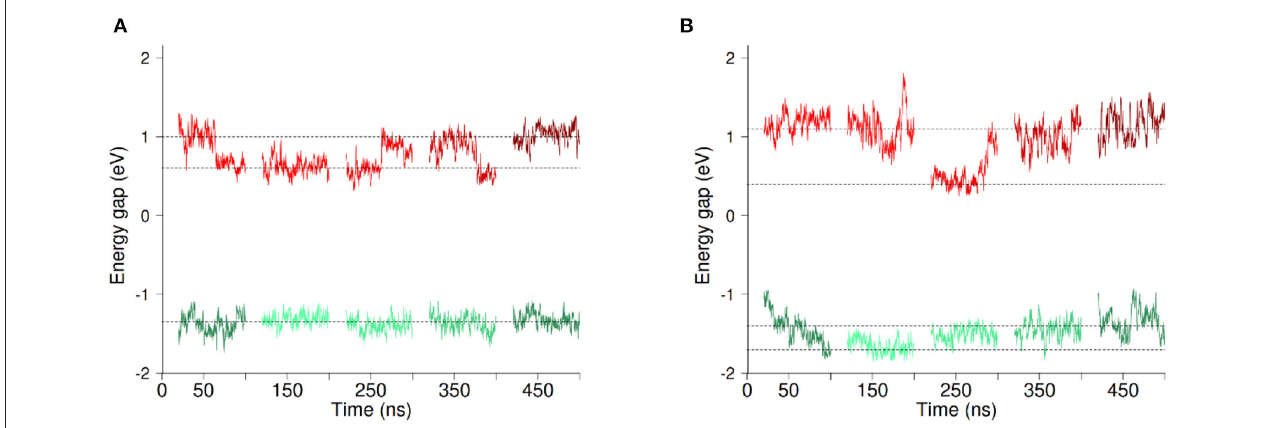
FIGURE 3 | Evolution of the vertical energy gap ∆ E ( E f − E i ) along MD simulations with O 2 (A) and without O 2 (B) . Each line section represents 80ns of MD simulation. The first three sections correspond to parts of the 300ns-long simulation (Set 1–3) while the two last sections come from the two independent 100ns-long replica simulations (Set 4 and 5). Energy gaps computed based on simulations in the initial (resp. final) redox state are shown in red (resp.green). Data shown correspond to running averages of ∆ E for clarity. Horizontal lines are guides to the eye.